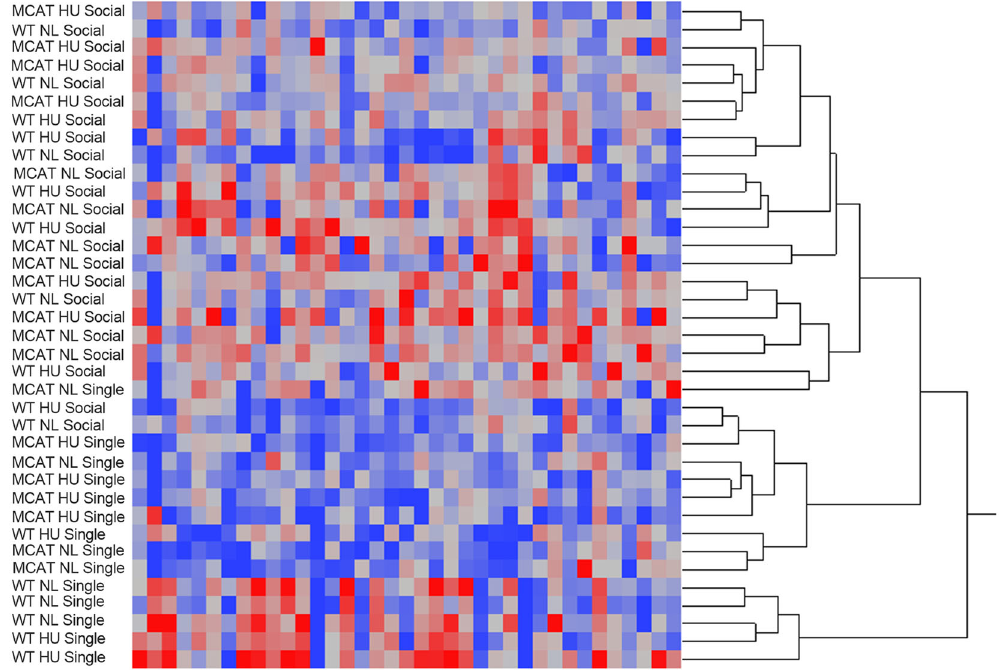
Fig. 1 Heatmap showing expression of a panel of 44 cytokines in hippocampus and hierarchical clustering analysis of eight experimental groups. Except for a few samples, clustering generally occurred by housing environment (single or social). Deeper shades of red: higher cytokine levels, deeper shades of blue: lower cytokine levels, off-white: no change in